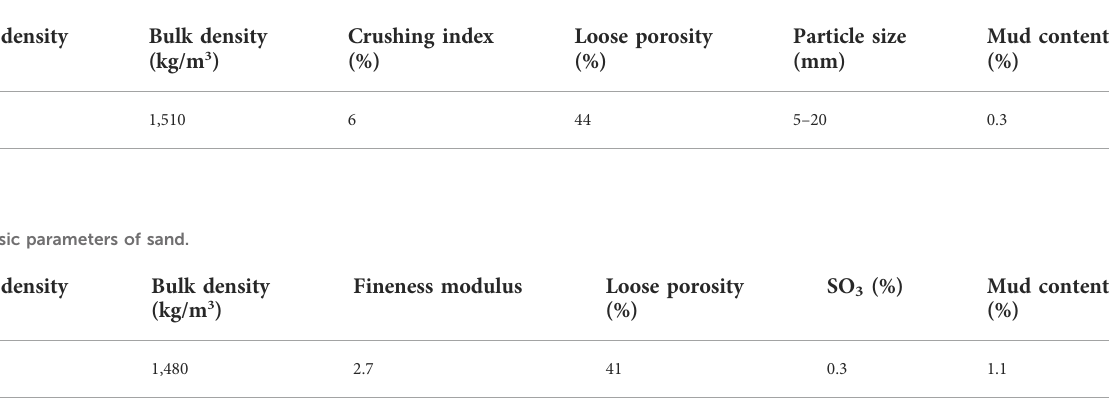
TABLE 2 Basic parameters of gravel.